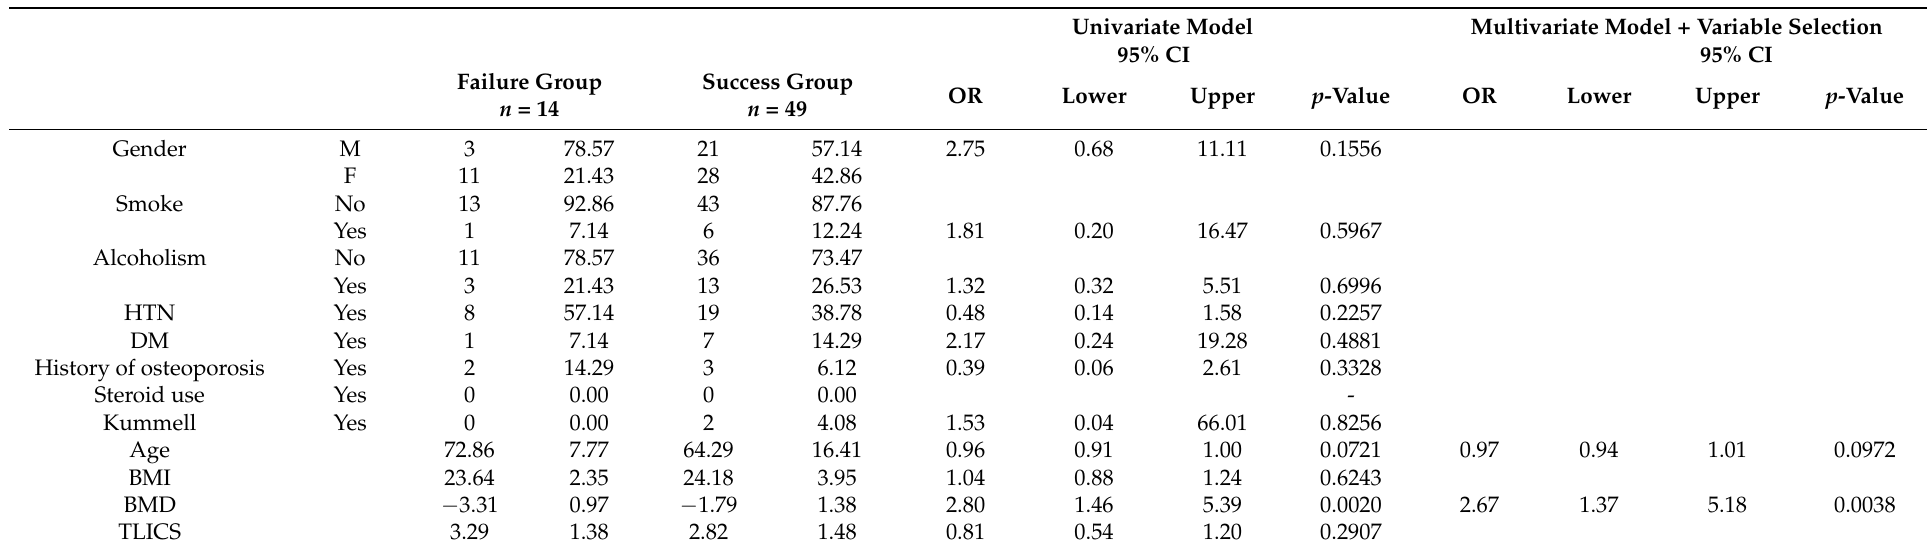
Table 3. Risk factors analysis for pain control failure after gray ramus nerve